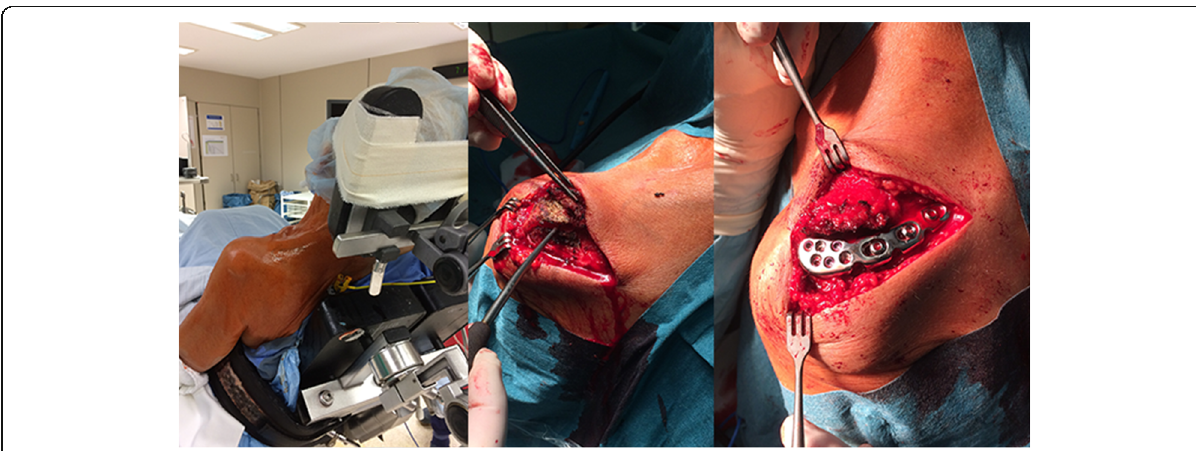
Fig. 3 Course of the surgery. The patient was placed in the beach-chair position without a tourniquet (left). A longitudinal incision was made along the scapular spine to visualise the entire os acromiale or acromial fracture (middle). The osteosynthesis plate was fixed anteriorly with angle-stable screws and posteriorly with angle-stable screws and at least one cortical compression screw to compress the fracture